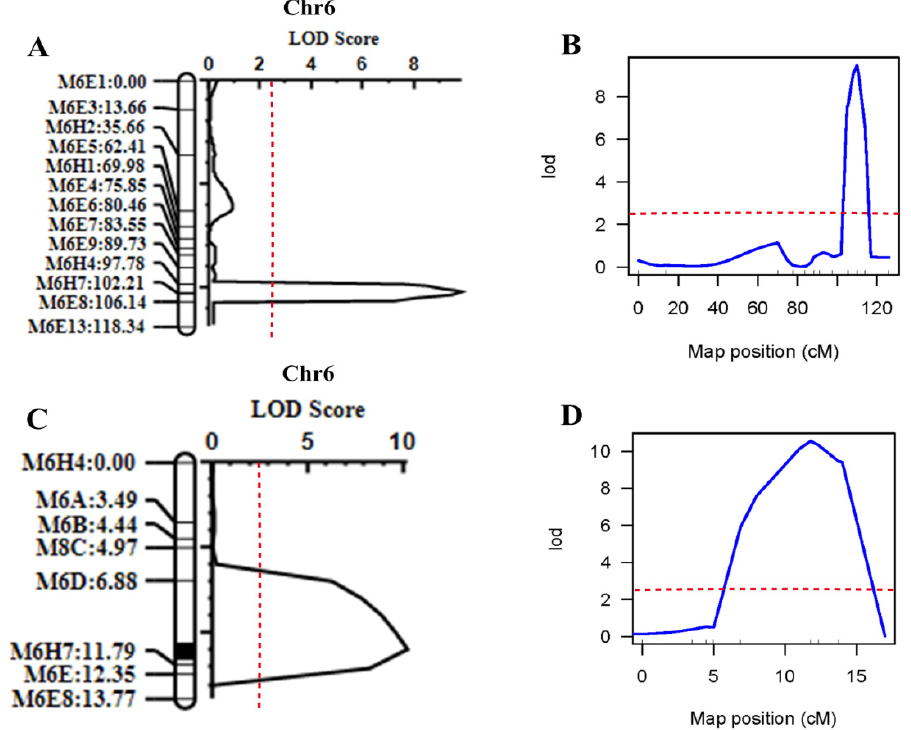
Figure 6. Positioning intervals for 2021 and 2022 SSC. ( A ) QTL IciMapping software 2021 QTL mapping results. ( B ) R/QTL software 2021 QTL mapping results. ( C ) QTL IciMapping software